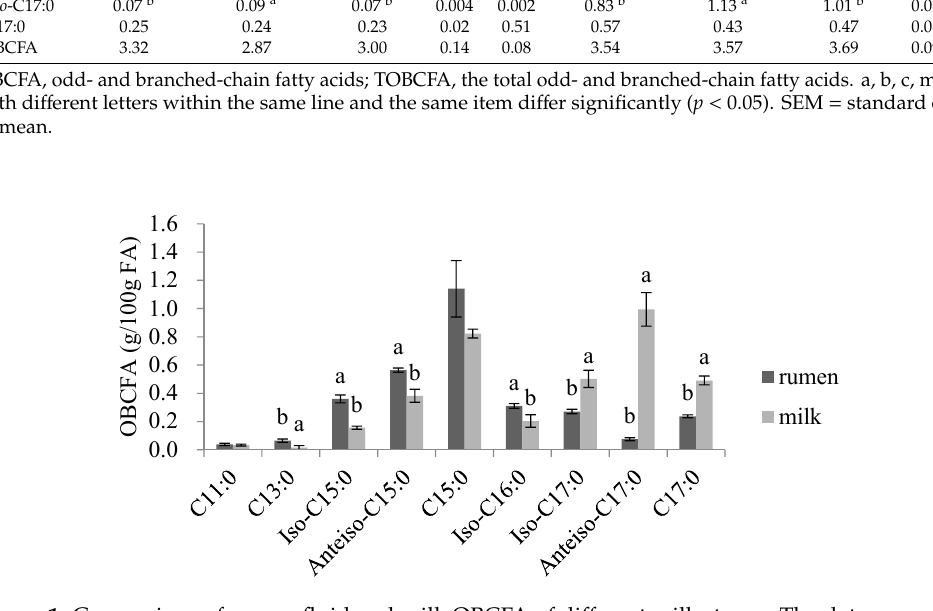
Figure 1. Comparison of rumen fluid and milk OBCFA of different milk stages. The data are means and deviations of three milk stages and error bars the show standard error of the mean. Bars without a common letter (a and b) differ ( p < 0.05). OBCFA, odd- and branched-chain fatty acids.